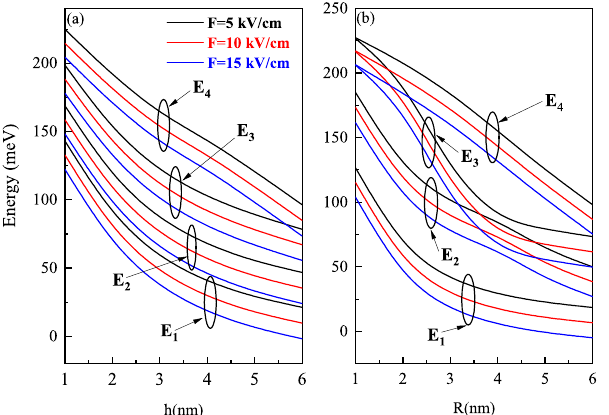
Figure 12. Ground and excited state energies as a function of the ( a ) oblate QD height (with R = 7 nm) and ( b ) prolate QD R (with h = 7 nm) for different values of the perpendicular electric field at F = 5, 10 and 15 kV/cm.